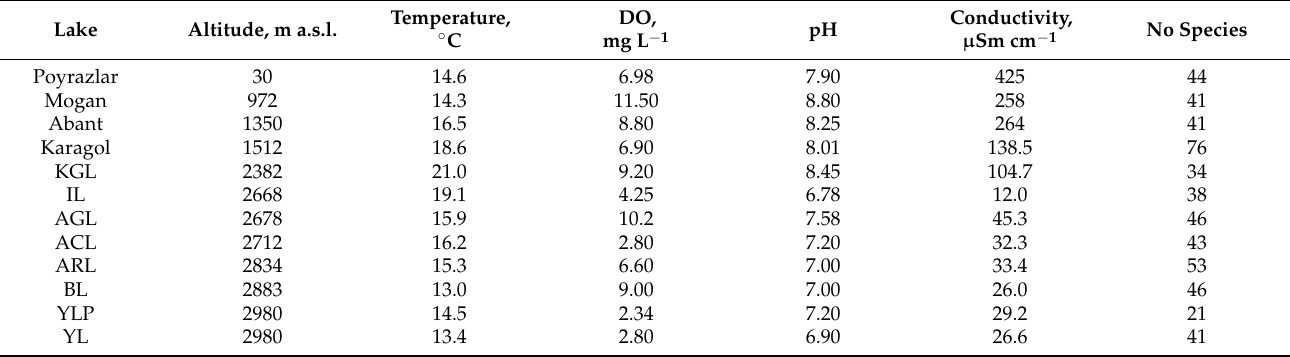
Table 3. Distribution of major environmental variables (averaged) and the diatom species number in the studied lakes Avusor and Koçdüzü, Artabel Lakes and other lakes in northern Turkey for comparative analysis.